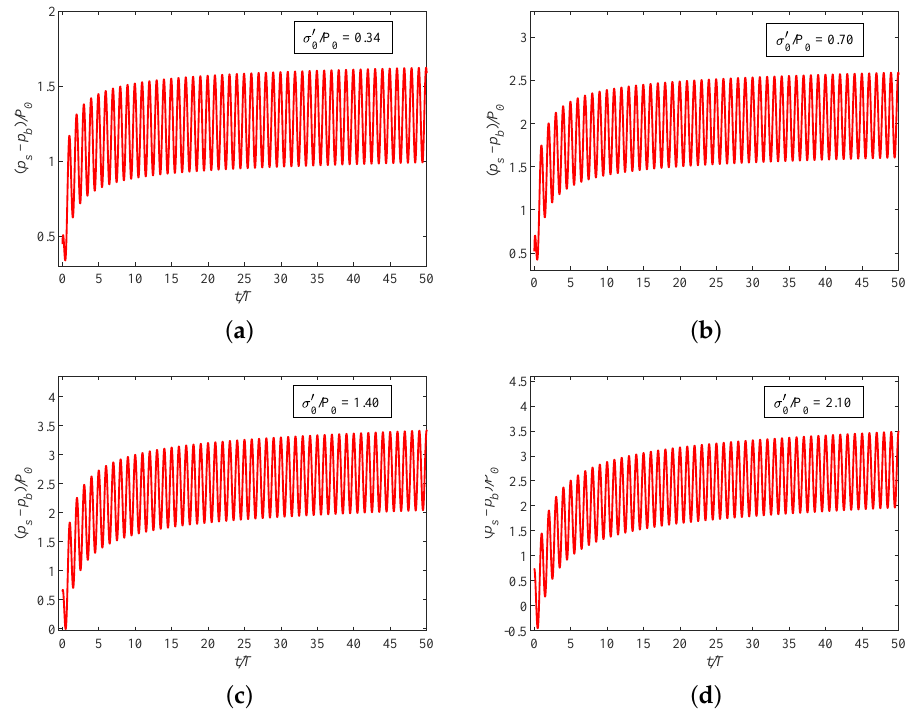
Figure 9. The development of the pore pressure over wave cycle ( t / T ) for Case 3; ( a ) (x, z) = (31.0, − 0.5) m; ( b ) (x, z) = (31.0, − 1.0) m; ( c ) (x, z) = (31.0, − 2.0) m; ( d ) (x, z) = (31.0, − 3.0)